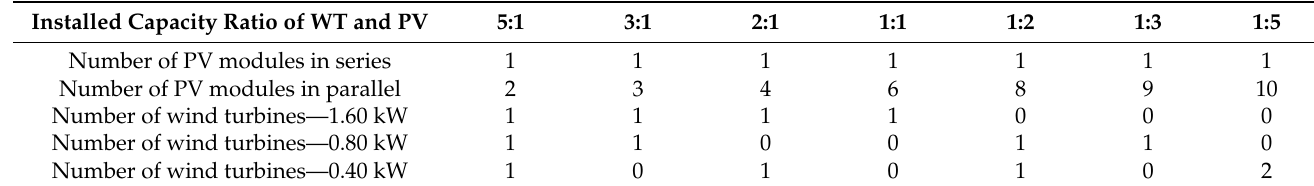
Table 6. Distribution strategies of total power with the different installed capacity ratios of WT and